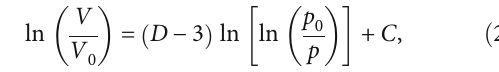
Table 4. The total pore volume increases correspondingly